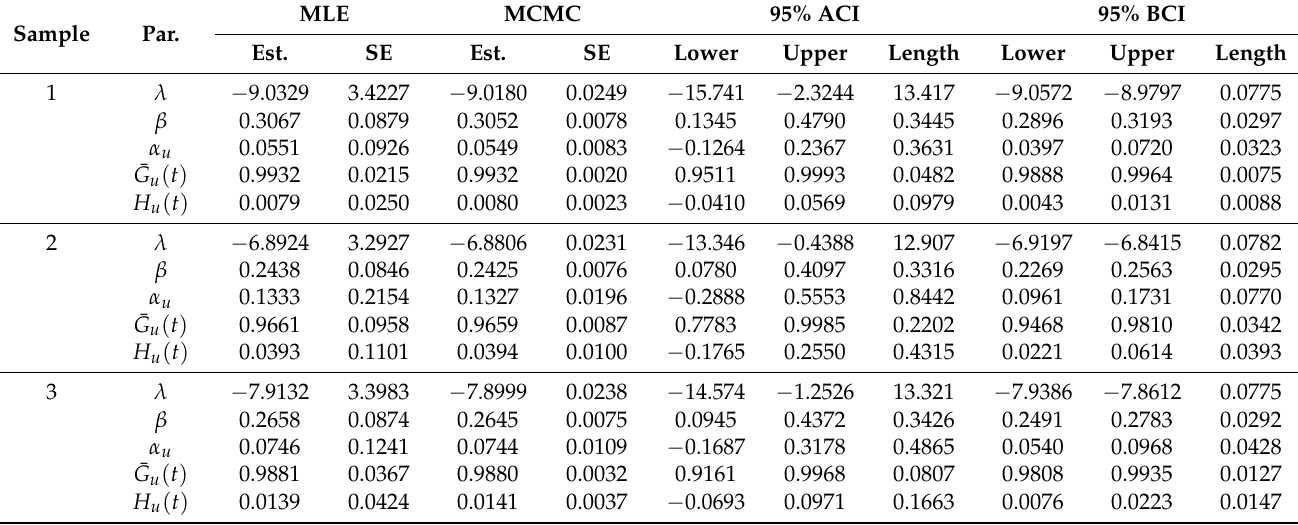
Table 6. Point and interval estimates from TLT